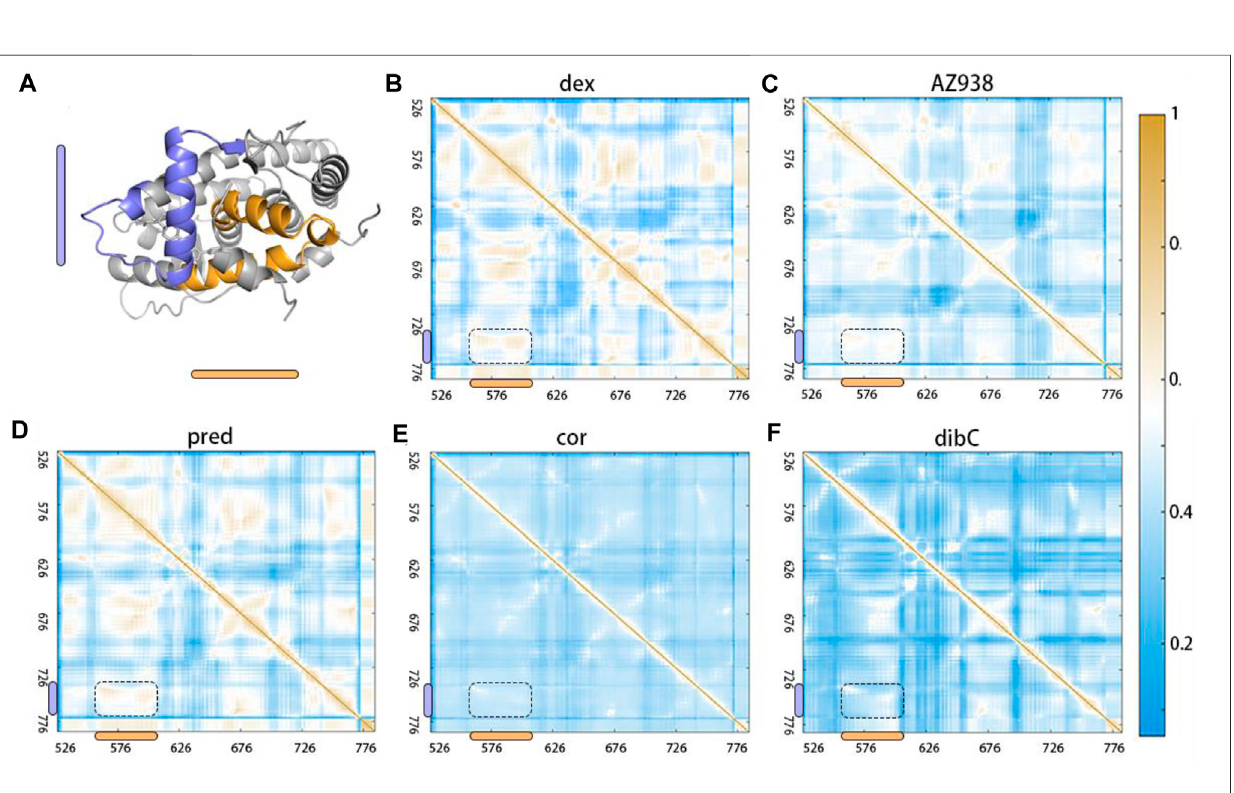
FIGURE 8 | Dynamic cross-correlation matrix (DCCM) calculations with obvious differences in the region shown in (A) . DCCMs of (B) dex-bound system, (C) AZ938-bound system, (D) pred-bound system, (E) cor-bound system, and (F) dibC-bound system. Positive regions (yellow) stand for correlated motions, whereas negative regions (blue) represent anti-correlated